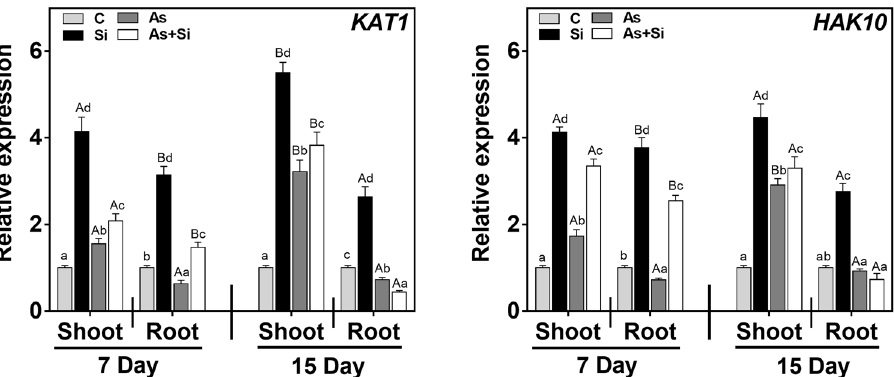
Figure 5. Differential expression of potassium absorption and assimilation related genes indicate their role under As and Si exposure in shoot and root of Oryza sativa var. IR64 at 7 and 15 d. Figure shows relative expression profile of potassium channel protein ( KAT1 ) and potassium transporter protein ( HAK10 ). All values are means of three replicates (n = 3, ± SD) and repeated twice. Different letters indicate the significant mean difference ( p < 0.05) between each treatment. The small latter (i.e. a, b, c and d) indicates the significant difference between treatment in same tissue type while capital latter (i.e. A and B) indicates the significant difference between duration among the same treatment in same tissue type. The endogenous actin gene of rice was used to normalize the genes relative to